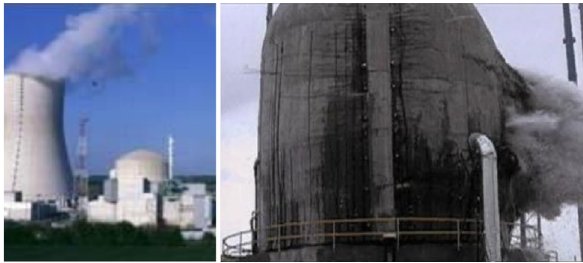
Fig. 1 Illustrative example for testing of large structures: (left) nuclear power plant with cooling tower and reactor containment structures built of reinforced-concrete composites; (right) Sandia Test on reduced size containment structure (1/4 of real